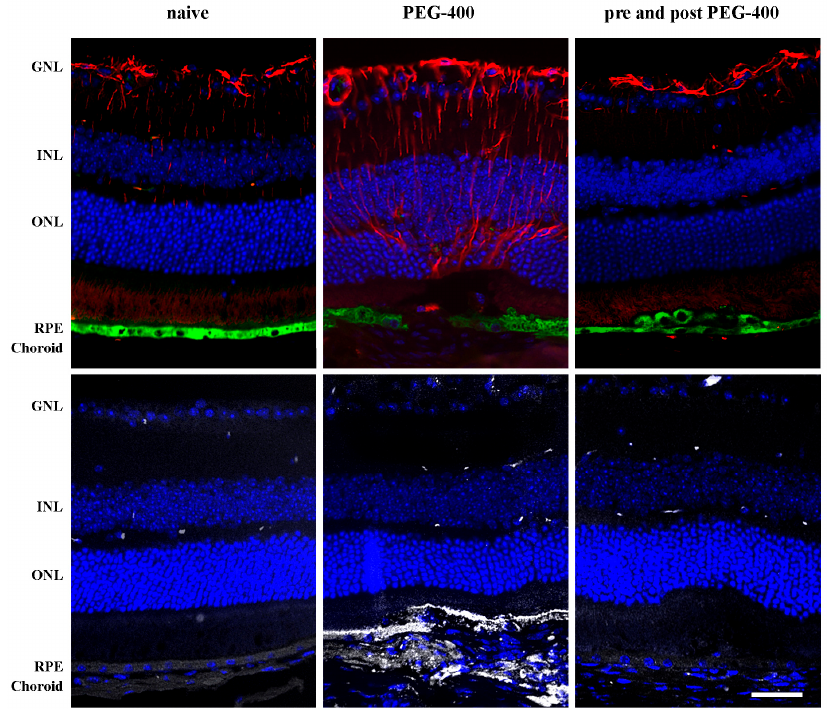
Figure 6. Dietary supplementation with mFAG normalizes overexpression of PEG-400-induced retinal damage tissue markers. Representative immunohistochemistry images of mice eyes as described in Figure 5. Panels represent glial fibrillary acidi protein- GFAP-)positive Müller cells ( red ), RPE65 specific staining of RPE cells ( green ), membrane attack complex (MAC) staining for activated macrophages ( white ), and the nuclei were counterstained with Hoechst 33342 ( blue ). Scale bar = 50 µ m. Retinal layers: GNL, ganglion nuclear layer; INL, inner nuclear layer; ONL, outer nuclear layer; RPE, retinal pigment epithelium.